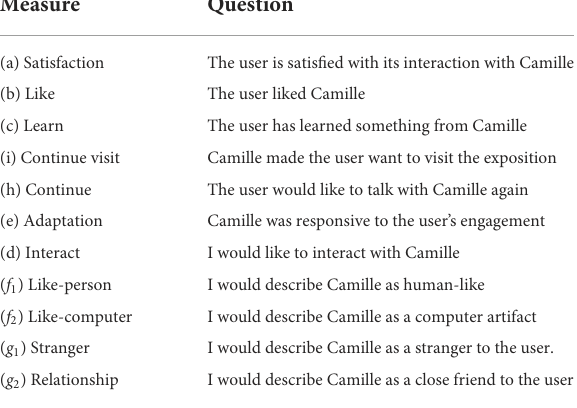
TABLE 3 Adjectives used to measure agent perceived warmth and